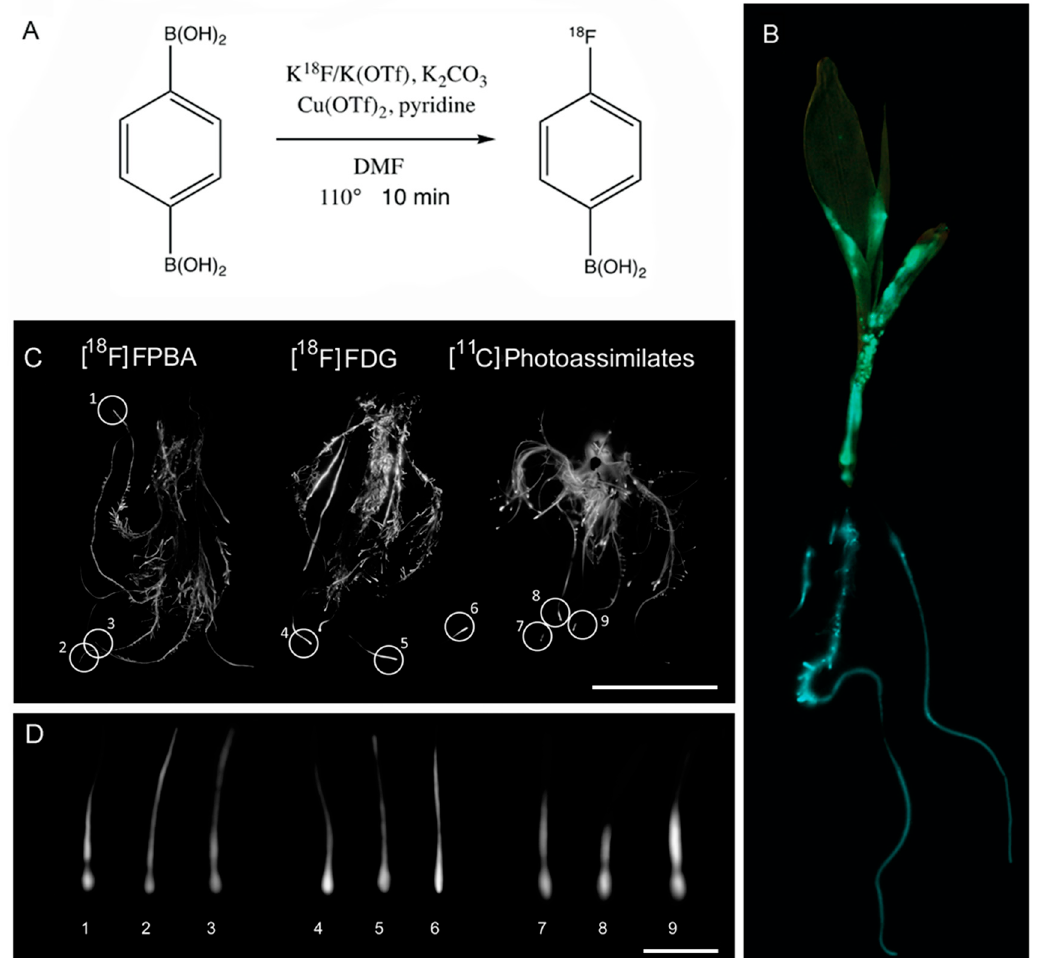
Figure 1. Synthesis and administration of a [ 18 F]FPBA radiotracer to maize seedlings (inbred B73). ( A ) Single vial synthesis of [ 18 F]FPBA from precursor 1,4-diboronic acid using a copper catalyst. ( B ) Radiographic image overlaid on visual image of five-days-old maize seedling after passive hydroponic administration of [ 18 F]FPBA radiotracer. ( C ) Three-weeks-old maize root radiographic images under passive administration of [ 18 F]FPBA, [ 18 F]FDG, or [ 11 C]CO 2 . Regions of interest appearing in circles are shown under greater magnification in panel D. ( D ) Primary root tips and elongation zones as they appear under radiographic imaging using [ 18 F]PBA, [ 18 F]FDG, or [ 11 C]CO 2 . Scale bar in C = 15 cm and in D = 0.5 cm.